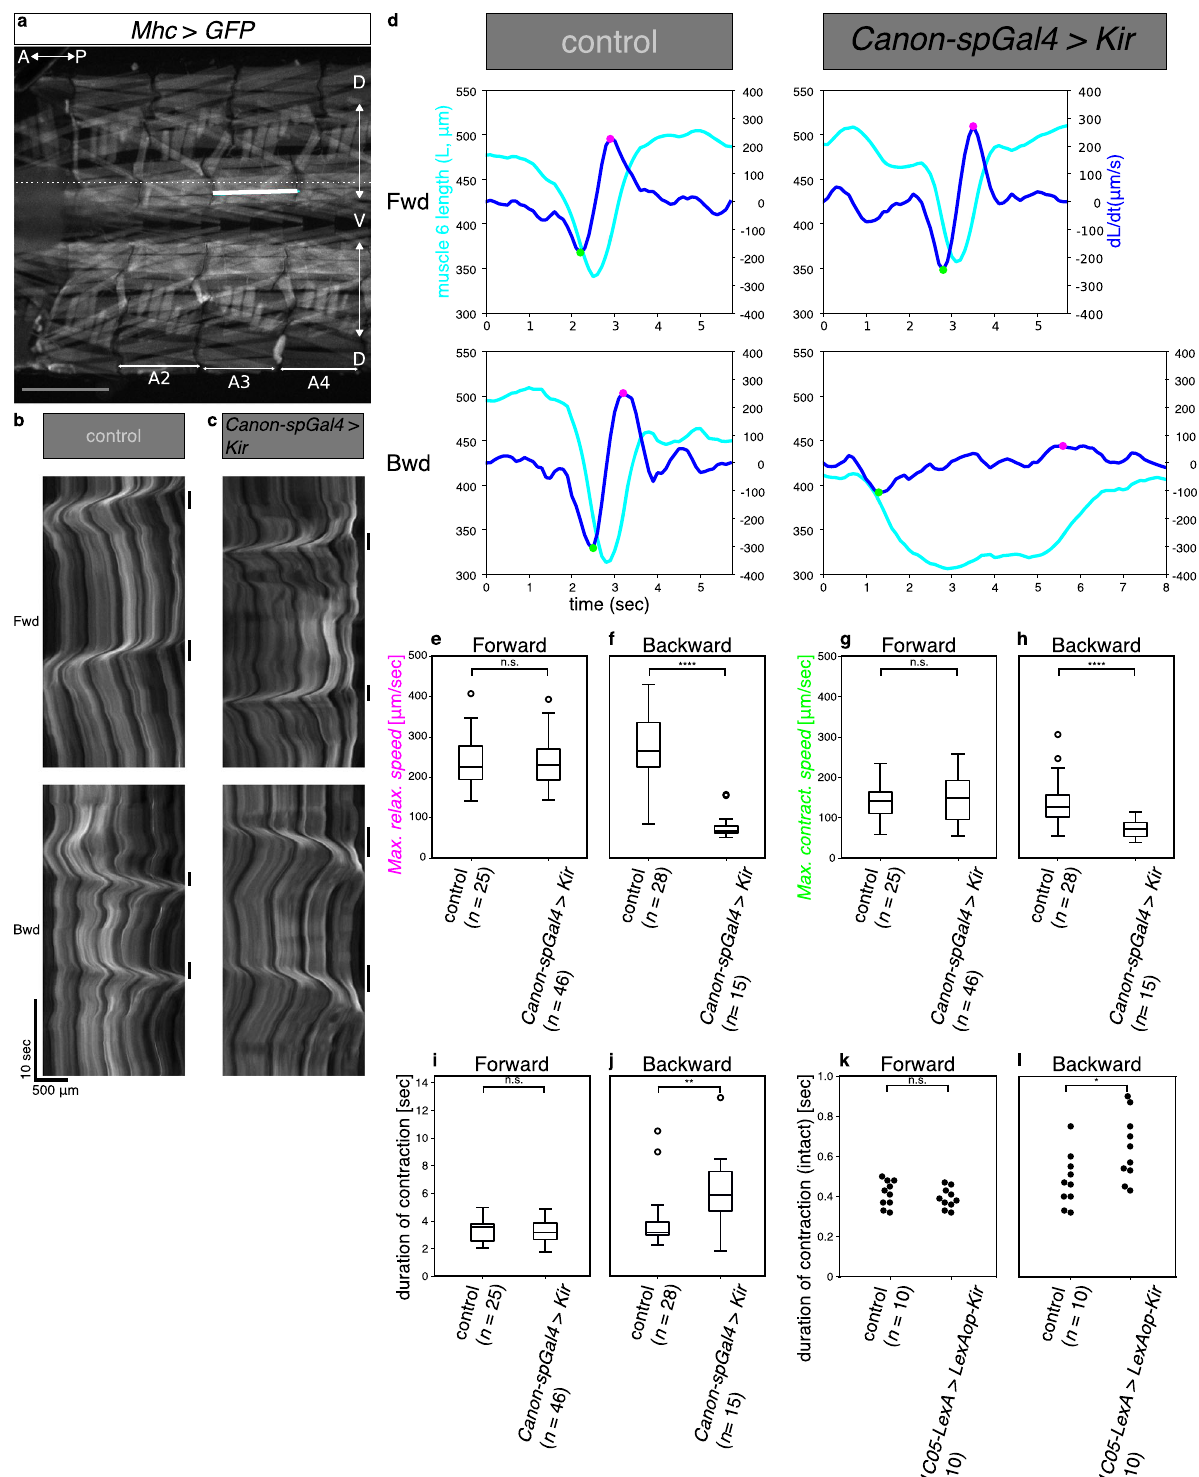
peristalses, when Canon neurons ’ activity was suppressed (Fig. 3b, c and Supplementary Movie